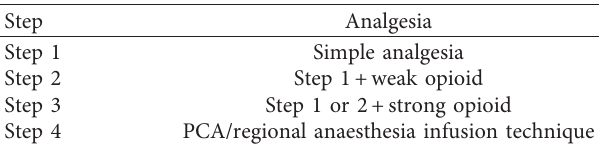
Figure 1: Trial timeline. Patients were recruited to three groups at postoperative day 1 (baseline) and followed for 48 hours (postoperative days 2 and 3). SC: standard care; DN: device with feedback to nursing staff; DNPT: device with feedback to nursing staff and pain team; IPO: International Pain Outcome Questionnaire. Table 1: Modified analgesic